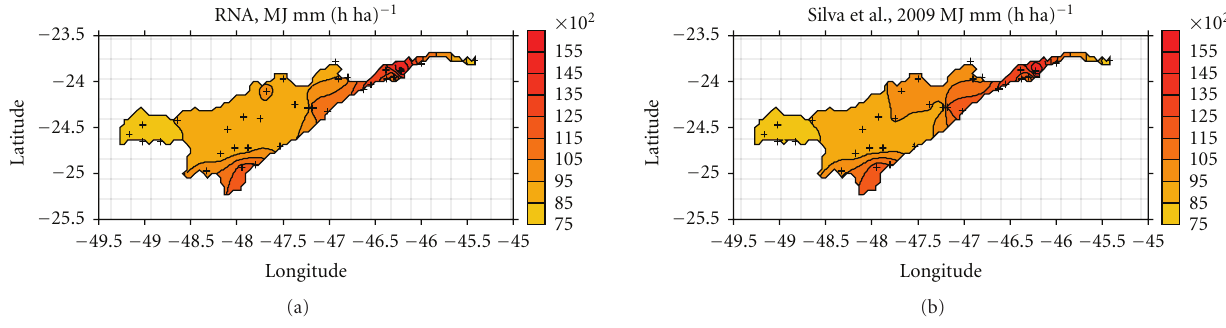
Figure 3: Spatial distribution of rainfall erosivity (MJmm(hha) − 1 ) for the Ribeira Valley and Coastal region of the State of S˜ao Paulo estimated through ANN and by Silva et al.